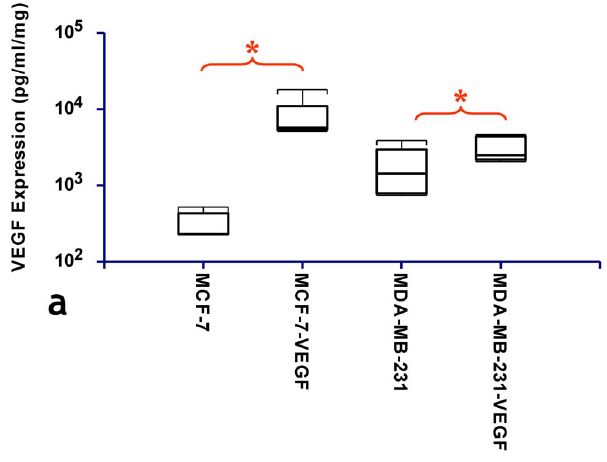
Figure 1. Generation of human breast cancer cell lines overexpressing VEGF. (a) Box-and-whisker plot comparing the VEGF expression levels (expressed on a logarithmic scale) assessed in lysates from MCF-7 and MCF-7-VEGF overexpressing tumors (*p=0.007 with the one-tailed Mann-Whitney U Test), and from MDA-MB-231 and MDA- MB-231-VEGF overexpressing tumors (*p=0.0476 with the one-tailed Mann-Whitney U Test), respectively.